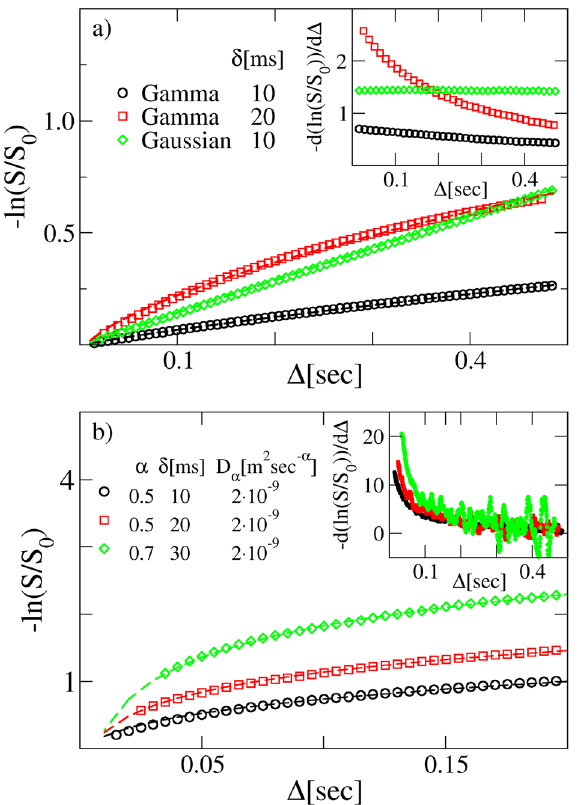
Figure 3. Panel ( a ) Superstatistical echo amplitudes. Main panel: comparison between different synthetic 9 m 2 s 1 and k 2 10 0.5 ) and NMR signals obtained from SS trajectories (symbols) with a Gamma ( θ − − = × = 9 m 2 s 1 and σ 10 m 2 s 1 ). PDFs and fitting curves obtained from Eq. (24) 2 10 10 a Gaussian ( D D = − − − − × ∗ = 0.01 T/m. Inset: trend of the derivative of the (dashed curves). The signals are obtained with a gradient g = logarithm of the normalized DW-NMR signals shown in the main plot. Panel ( b ) CTRW echo amplitudes. Main plot: comparison between different synthetic NMR signals obtained from CTRW trajectories (symbols) and 0.02 T/m. fitting curves obtained from Eq. (24) (dashed curves). The signals are obtained with a gradient g = Inset: trend of the derivative of the logarithm of the normalized NMR signals shown in the main